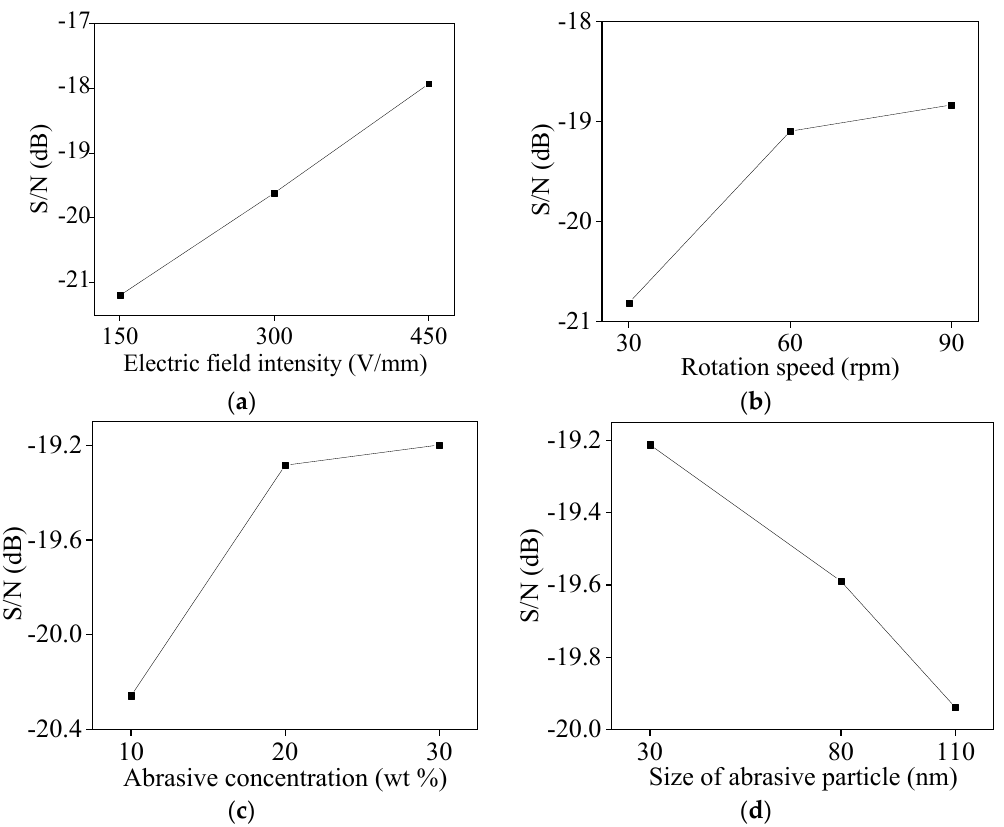
Figure 5. Influence of process parameter level on surface roughness (S/N average response): ( a ) electric field intensity; ( b ) rotation speed; ( c ) abrasive concentration; ( d ) size of abrasive particle.